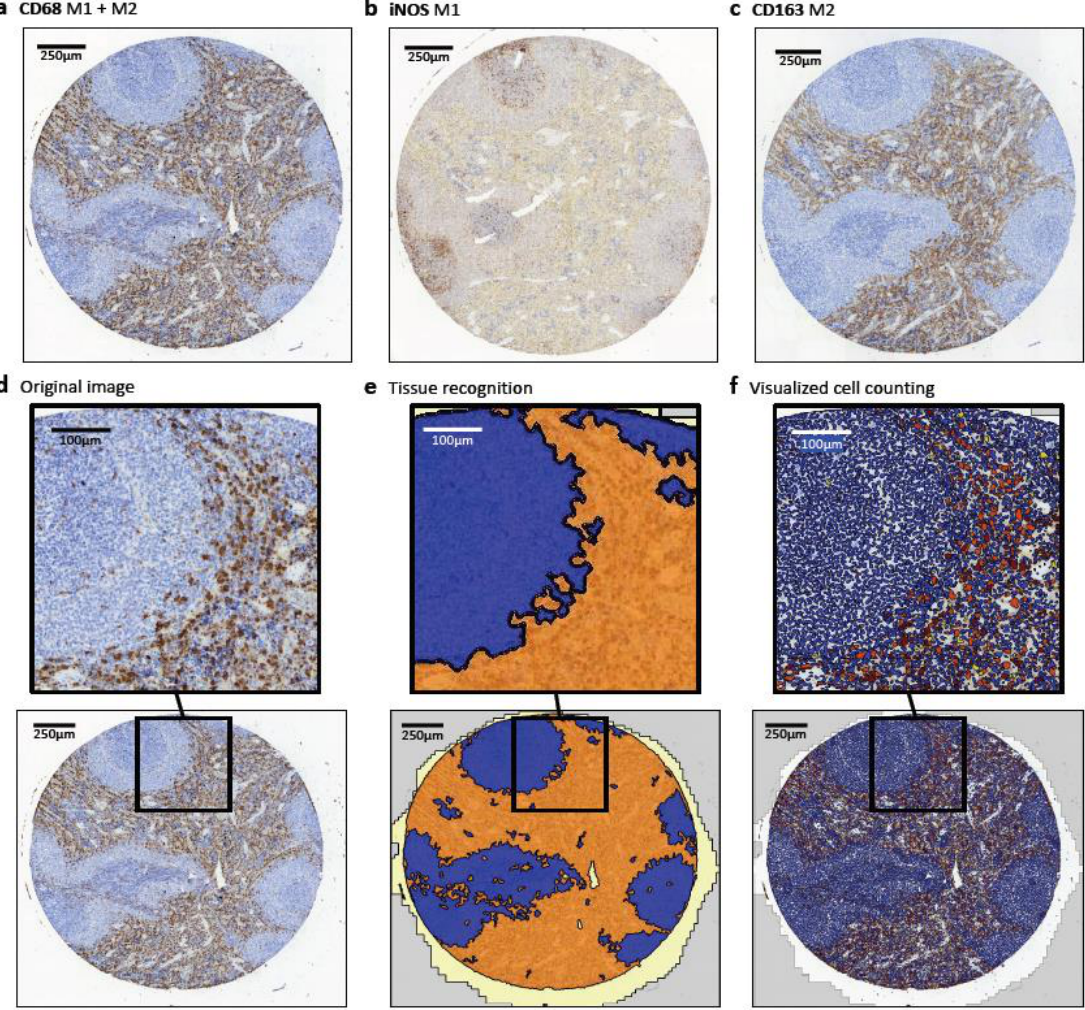
Figure 5. Staining and analysis of the TMA. Image analysis of Tissue Studio in a TMA core of spleen tissue. Expression of the macrophage markers CD68, CD163 and iNOS is shown. CD68 ( a ) is the best-established pan-macrophage marker for M1 and M2 polarized macrophages. iNOS ( b ) is used as a marker for M1 polarized macrophages. CD163 ( c ) is an established M2 macrophage marker. ( d ) Original image with CD68 staining of a TMA core used for image analysis with Tissue Studio. ( e ) Division into the different region of interests (ROI): white pulp (blue), red pulp (orange) and white space (light yellow) made with Tissue Studio. ( f ) Cell classification into CD68 negative cells (blue) and positive cells with the different intensities 1 (yellow), 2 (orange) and 3 (red). parameters according to the intensity of the stains. The parameter settings were identical for the tissue types and stains. Representative results are shown in Figure